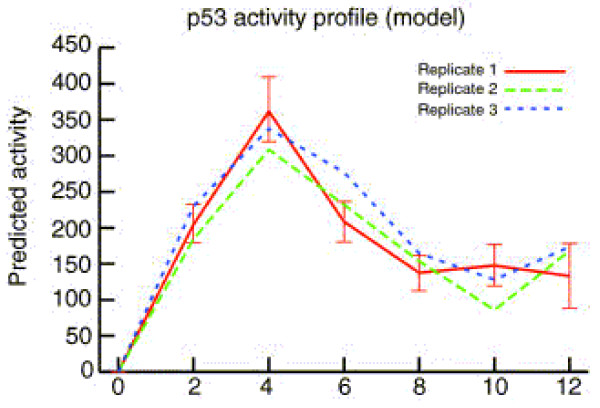
Activity profile of p53 derived in Barenco et al. (2006) [8].